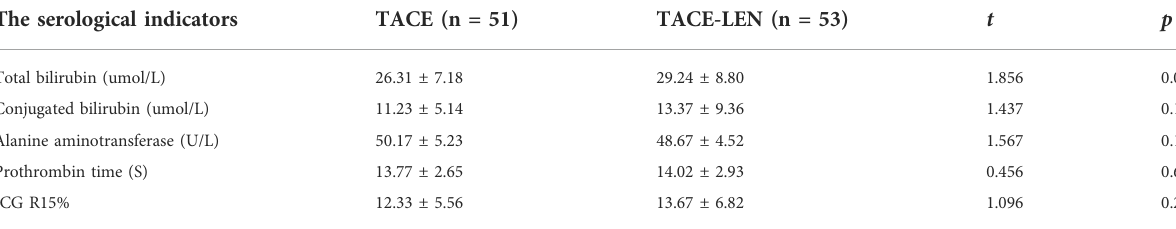
TABLE 3 The indicators for hepatic function 8 weeks after